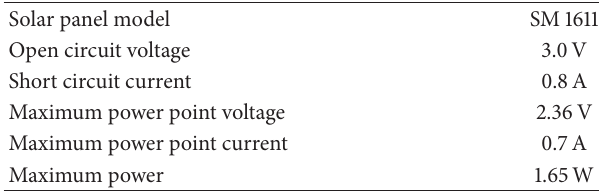
Table 2: Solar panel model and specifications.